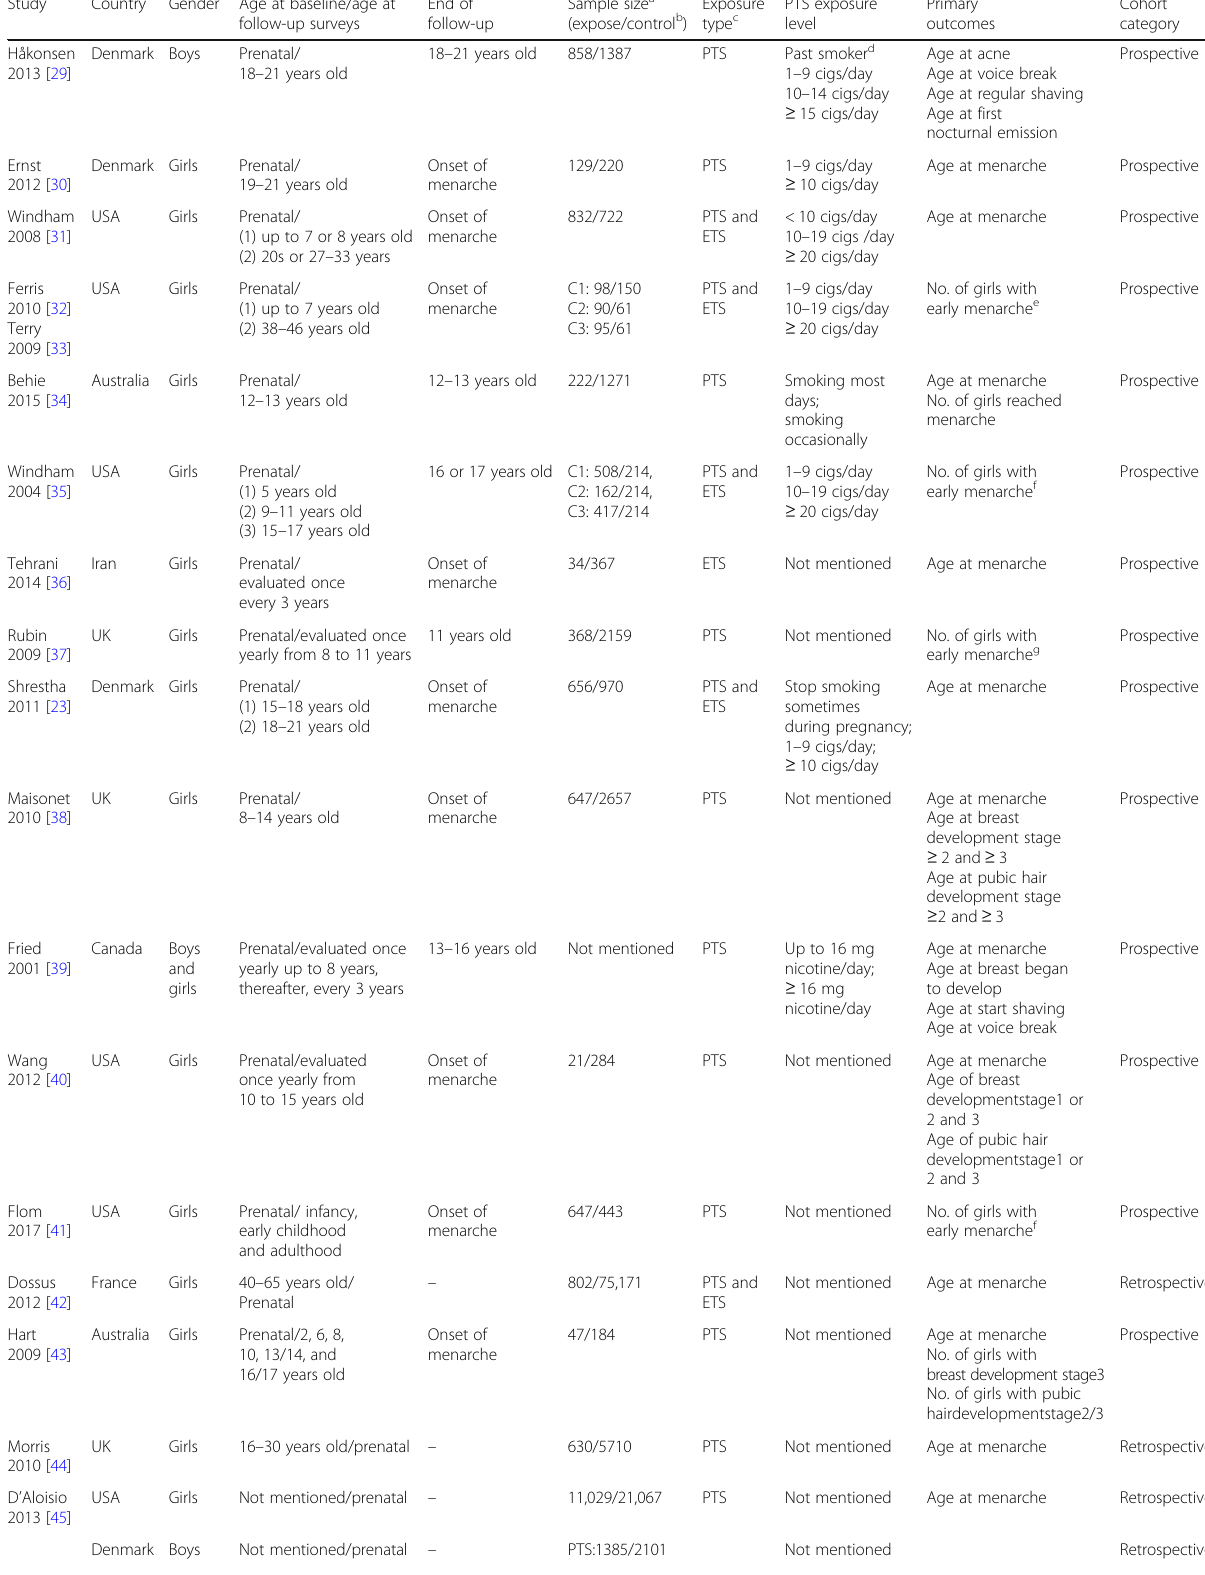
Table 1 Characteristics of Included Studies Study Country Gender Age at baseline/age at follow-up